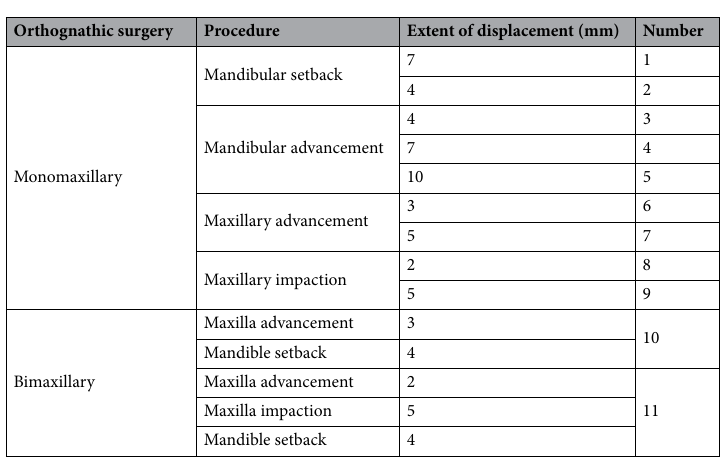
Table 1. Overview of the 11 different orthognathic surgery simulations per data